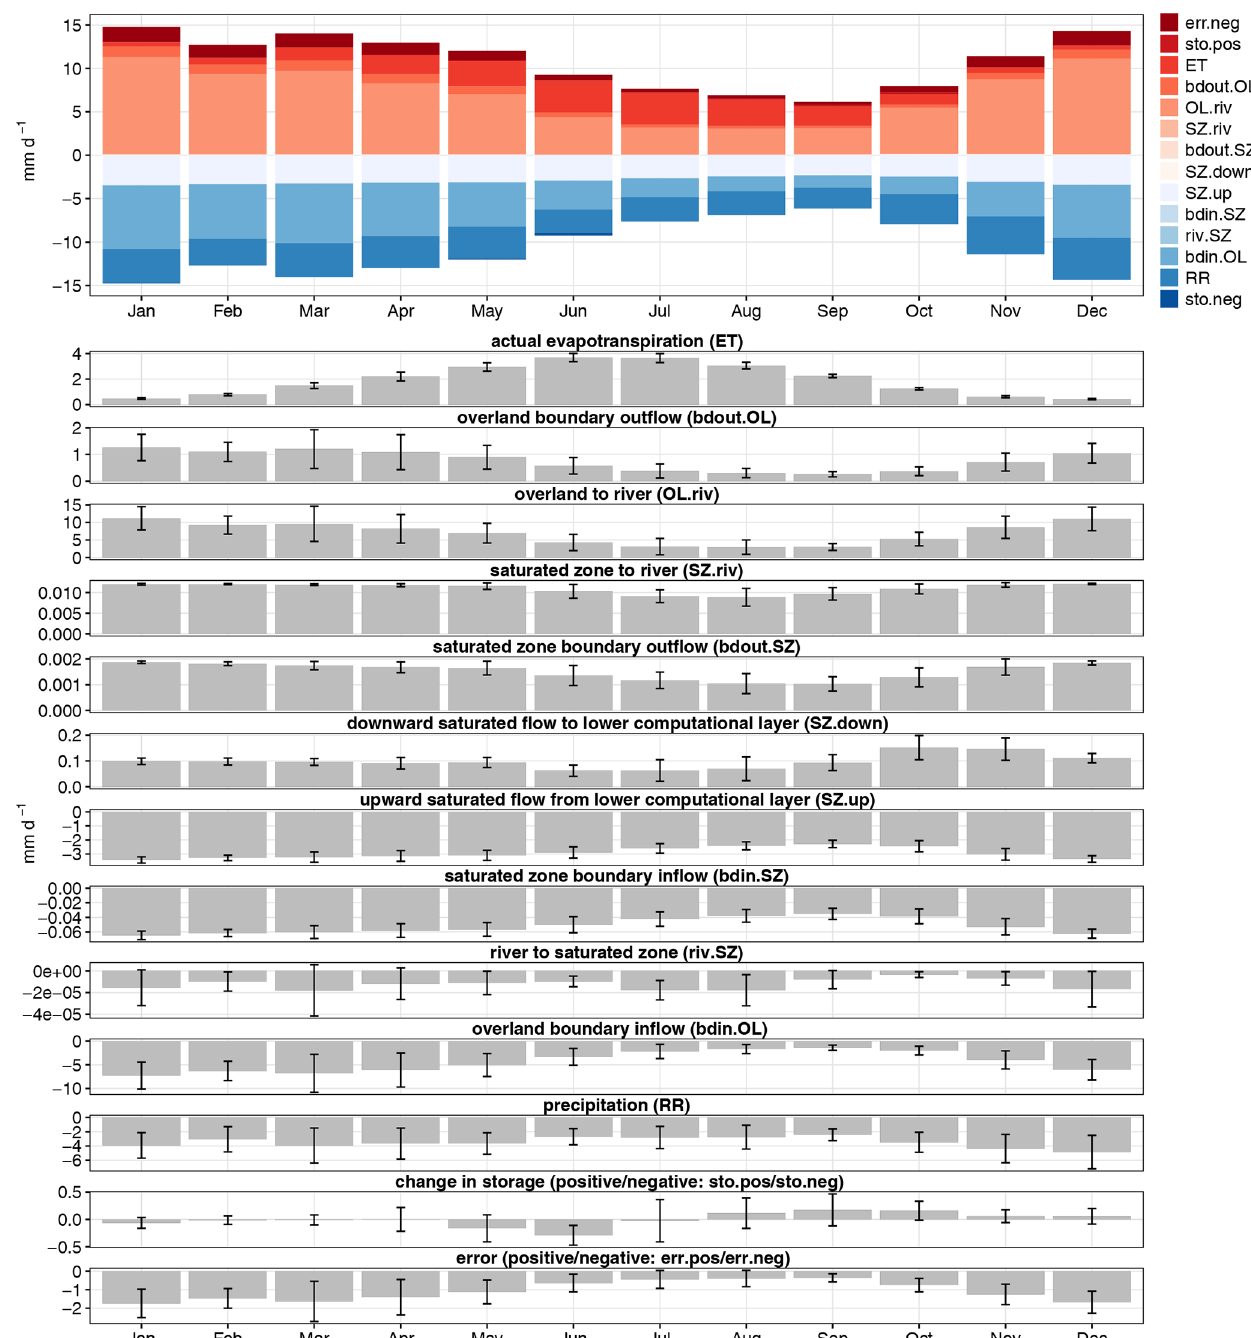
Figure 10. Simulated mean monthly water balance of the Dauges mire (2001–2013). Figures follow the MIKE SHE water balance conven- tion: inputs are negative, outputs positive, change in storage positive when storage increases, and the water balance error is the sum of all inputs and outputs. Whiskers show the standard deviation. Top plot: see titles of bottom plots for variable codes.